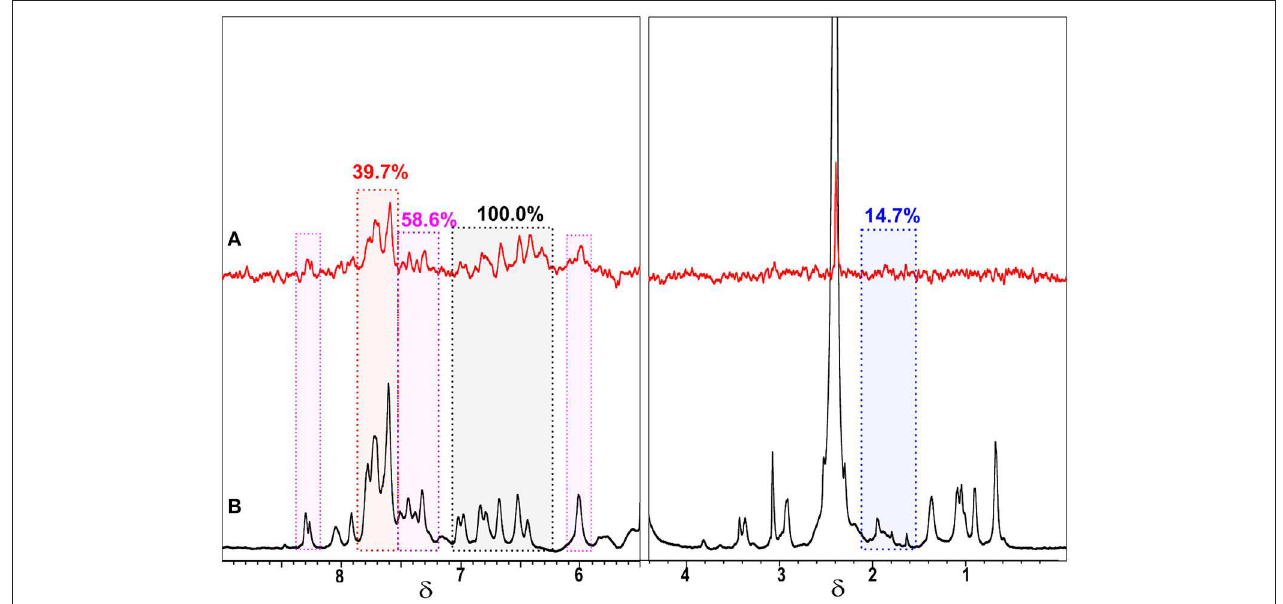
FIGURE 5 | Off-resonance STD spectrum (A) and STD diff-spectrum (B) obtained by applying 10.0s of saturation time and used for the calculation of A STD and consequent epitope map, highlighting the contribution (proximity) of each group present on CBLAU (5mM), bipy (58.6%) (pink), butyl protons between the DPPB units (14.7%) (blue), lawsone (100.0%) (black), and DPPB (39.7%) (red) to CT-DNA (50 µ M) surface.